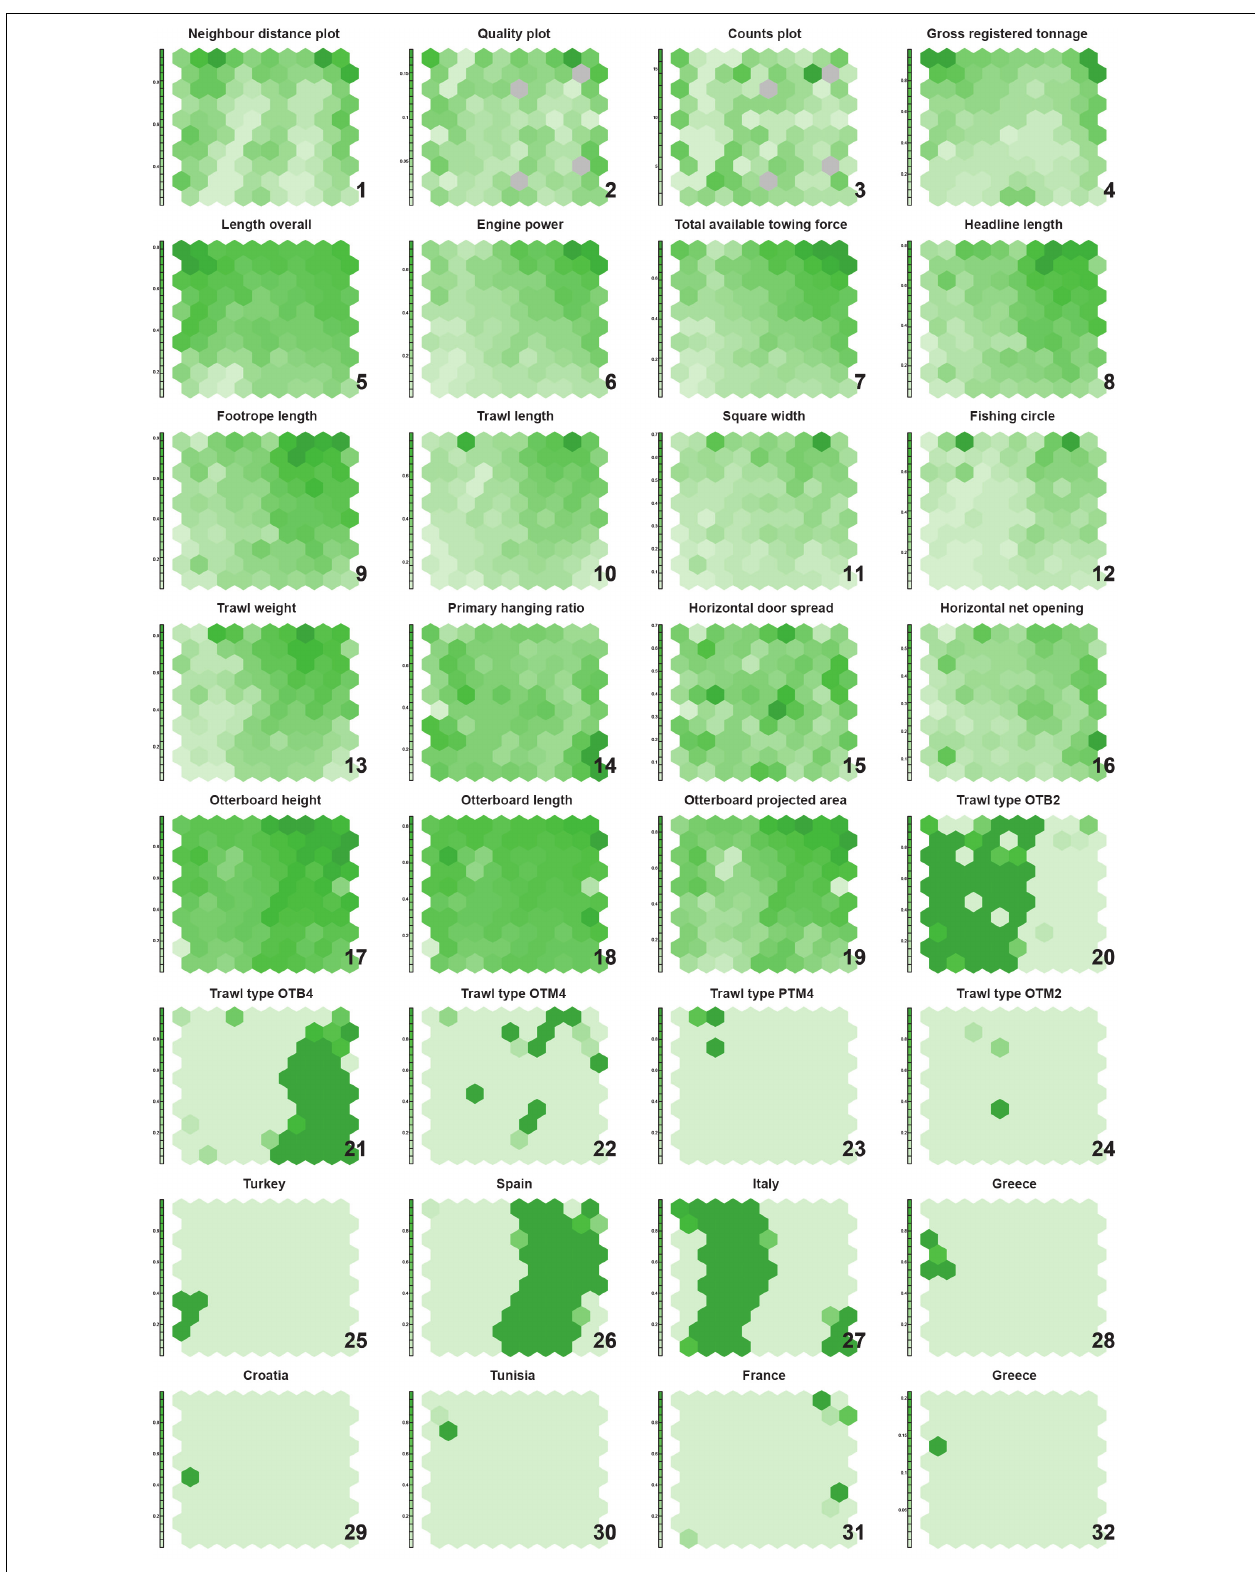
FIGURE 4 | Trained SOM. The distribution pattern of the observed variables, normalized between 0 and 1, is expressed in the SOM using a color scale. Darker areas correspond to the higher values of each variable.